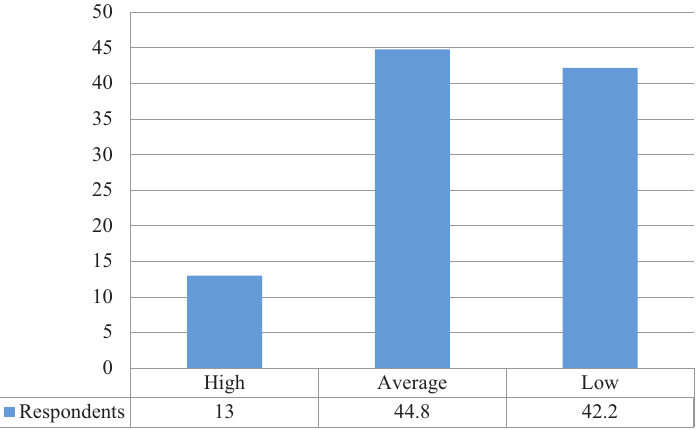
Figure 2. Quantitative indicators of speech development by the method of “Invent a